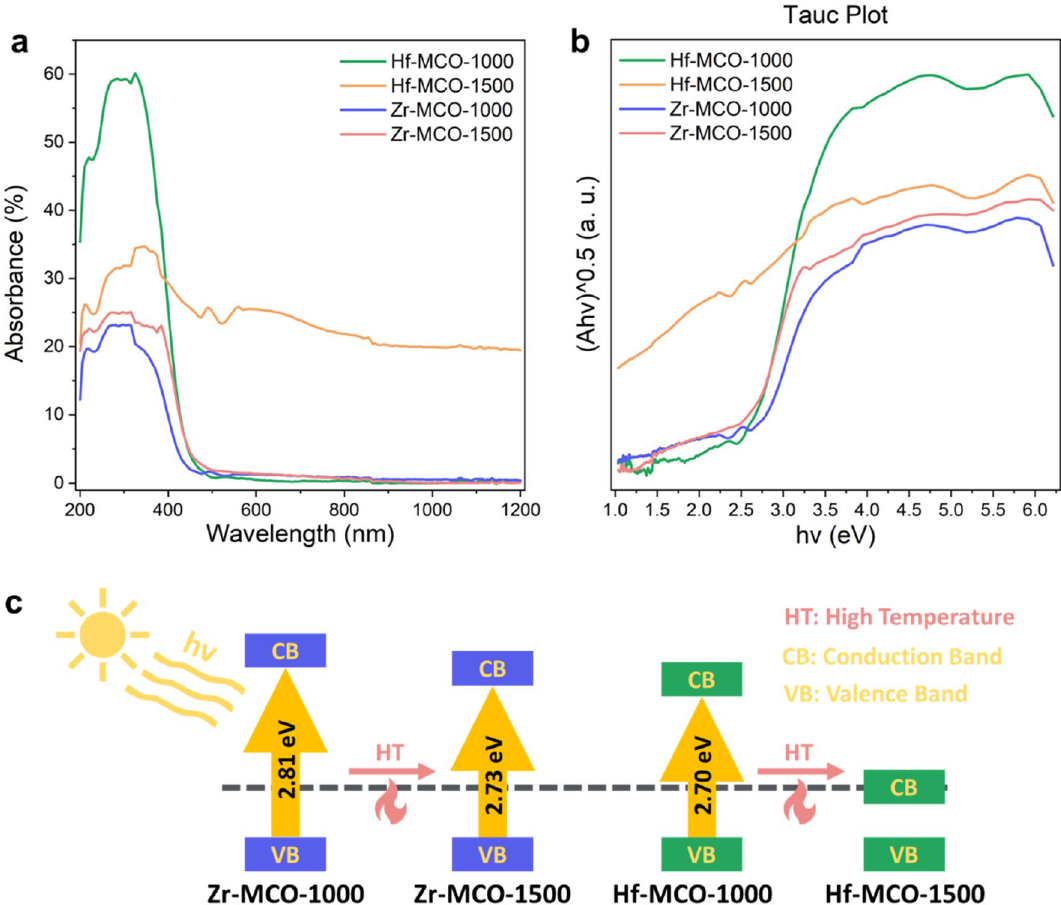
Figure 6. UV–vis spectra ( a ) and related Tauc Plot ( b ) of Hf-MPO-1000, Hf-MPO-1500, Zr-MPO-1000 and Zr-MPO-1500. ( c ) Schematic illustration of bandgap decreases by temperature-induced oxygen